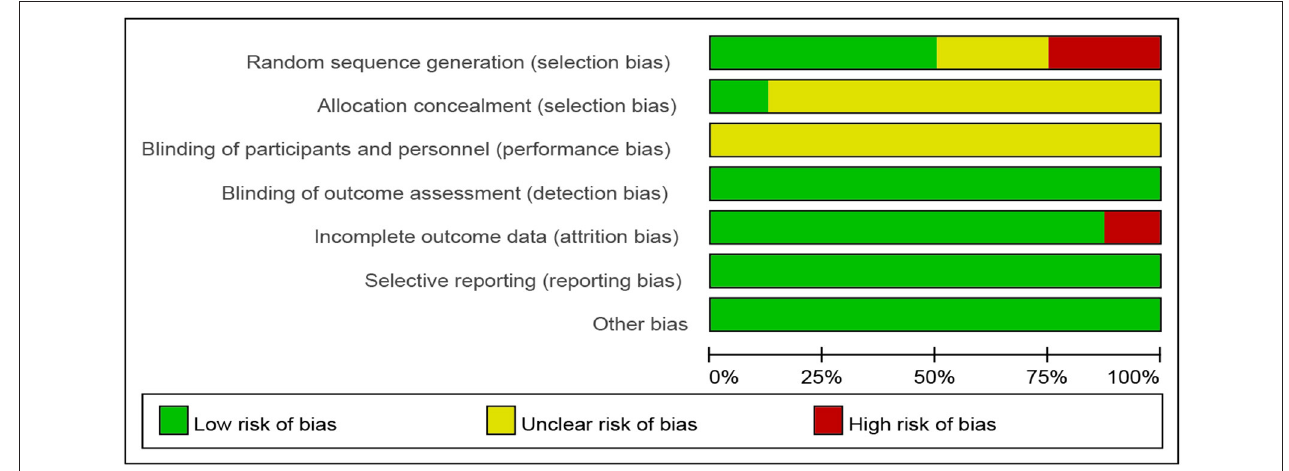
FIGURE 2 | Risk of bias graph: each risk of bias item is presented as